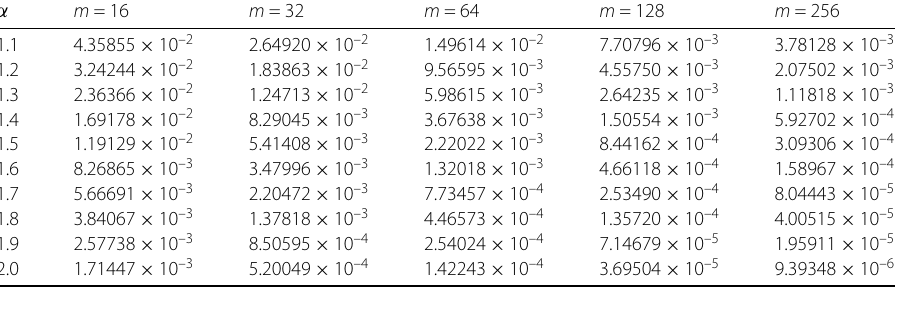
Figure 9 Exact and numerical solutions for fixed values of m = 64, ρ = 1, and α =